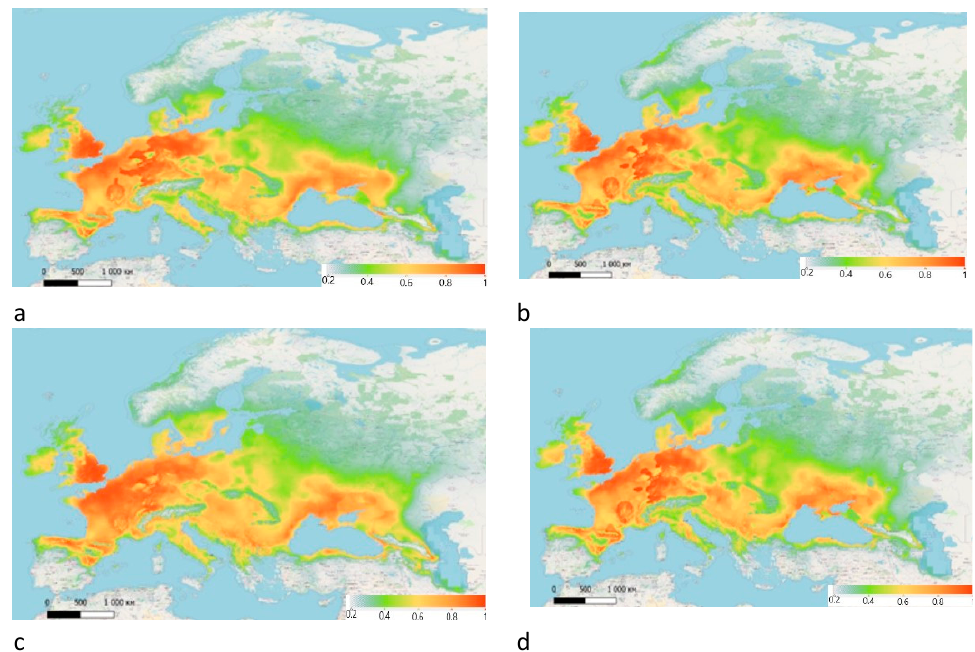
Figure 5. Predicted bioclimatic ranges of Z. tenebrioides : ( a ) 2050, according to RCP 2.6 scenario; ( b ) 2070, according to RCP 2.6 scenario; ( c ) 2050 according to RCP 8.5 scenario; ( d ) 2070, according to RCP 8.5 scenario. Table 2. Predicted areas (km 2 ) of bioclimatic ranges of Z. tenebrioides . Climatic Scenario Climatic